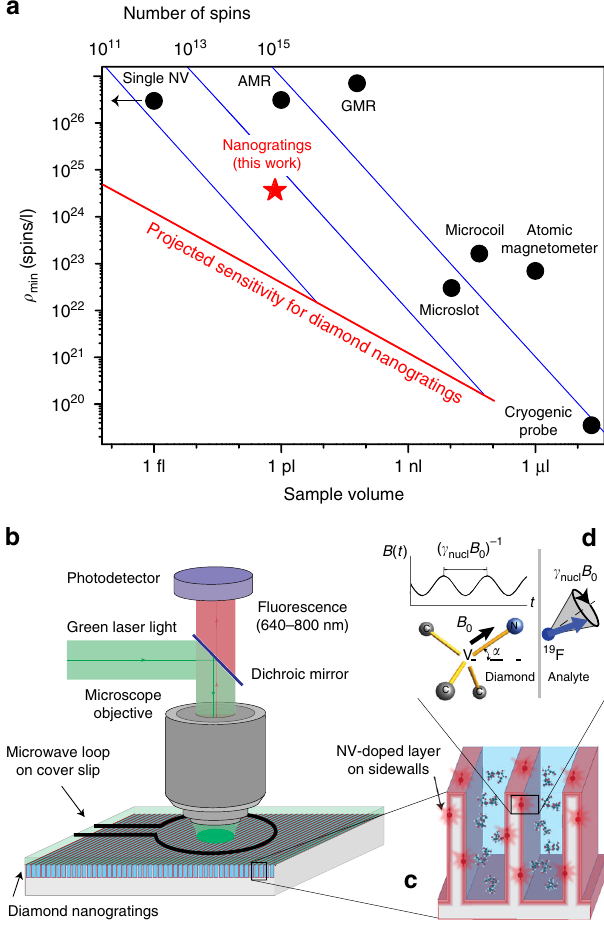
Fig. 1 Picoliter NMR. a Overview of ambient-temperature NMR techniques for small volumes. Points represent experimental values for minimum-detectable nuclear spin concentration in 1 s with SNR = 3 for different techniques: microslot 7 , microcoil 8 , cryogenic probes 22 , atomic vapor magnetometers 25 , giant magnetoresistance (GMR) sensors 23 , anistropic magnetoresistance (AMR) sensors 24 , single NV centers 14 , and NV-doped nanogratings (this work). The solid red line is the projected sensitivity for diamond nanogratings (Eq. (1)), exhibiting volume − 1/2 scaling (see Supplementary Note 1). Solid blue lines indicate constant numbers of spins. b Epi fl uorescence diamond NMR set-up. c The sensor region consists of dense, high aspect-ratio diamond nanogratings fabricated via interferometric lithography and doped with NV centers. d